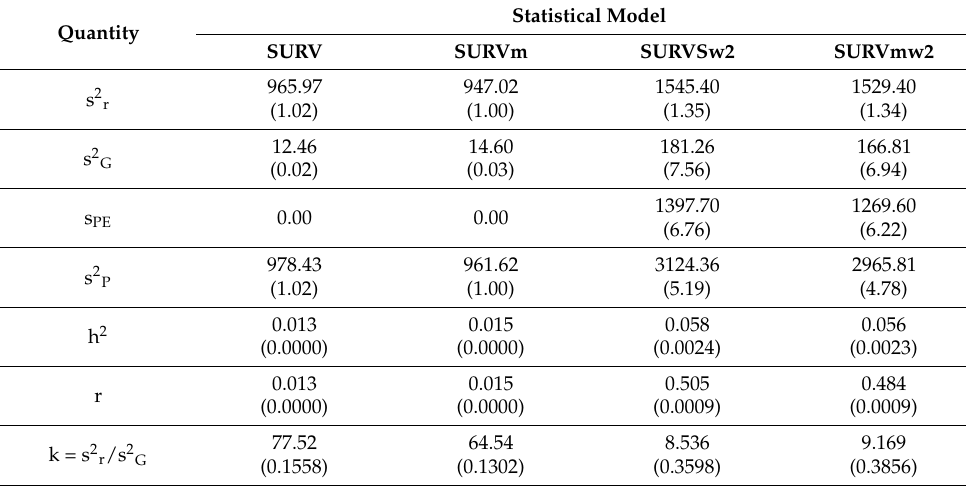
Table 4. Population genetic parameters (mean estimation errors in